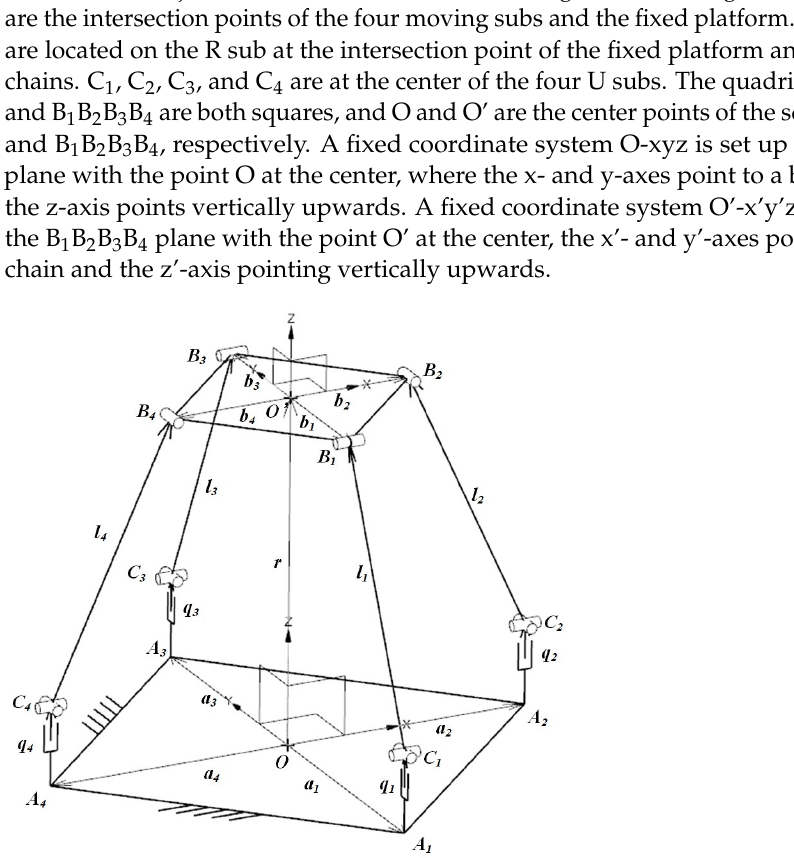
Figure 1. Sketch of the adjustment mechanism.